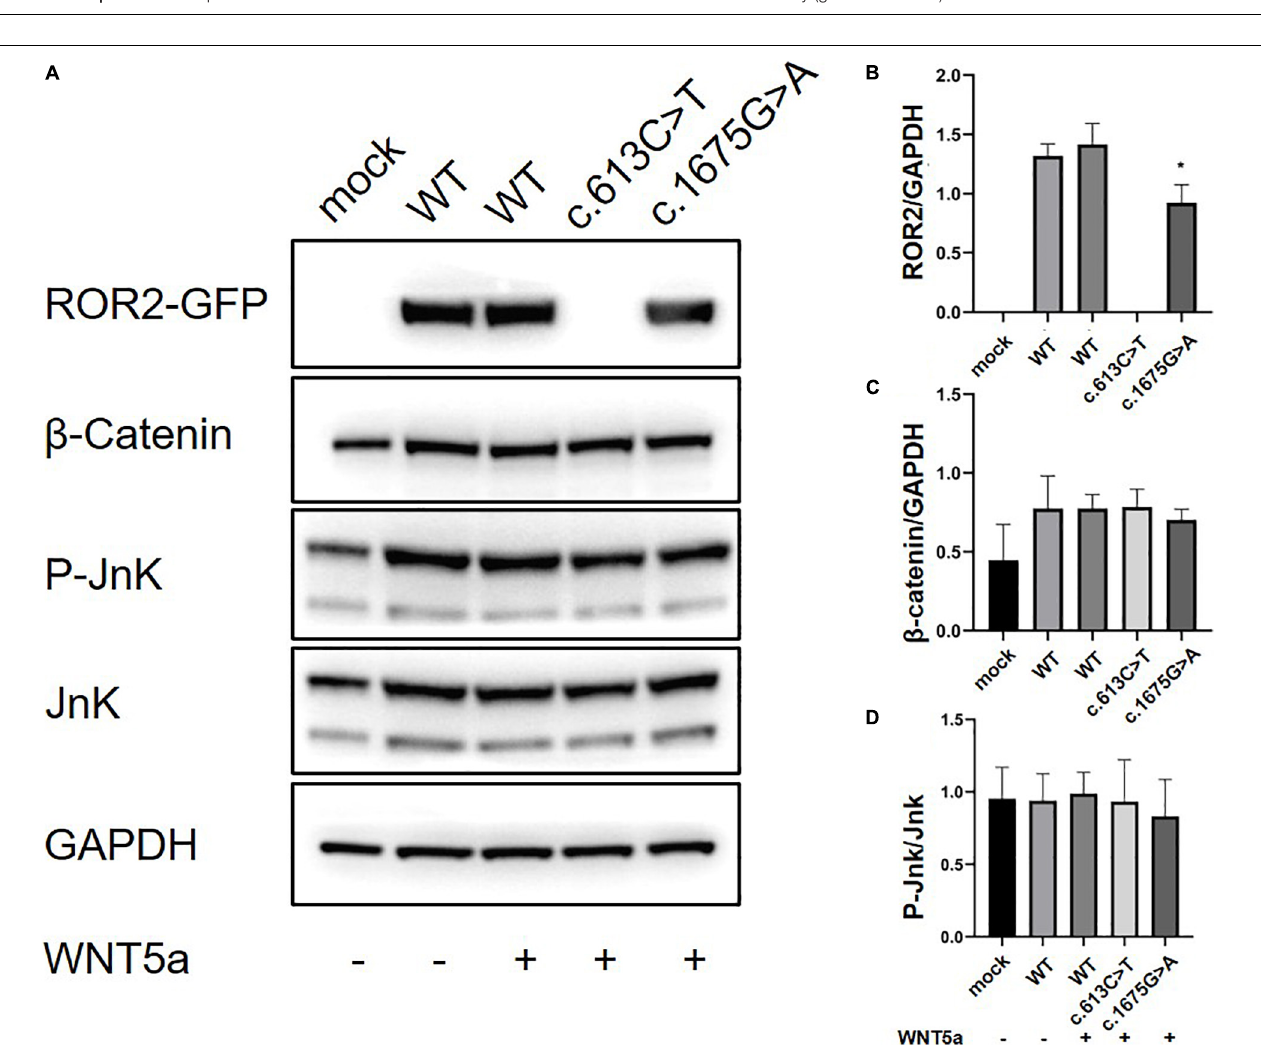
FIGURE 3 | Modulation of non-canonical Wnt signaling in HeLa cells with the supplementation of Wnt5a in general culture conditions. The ROR2-GFP, β -Catenin, P-JnK, JnK levels in HeLa cells with 100 ng/ml concentration of Wnt5a (A) Western blot for Ror2 [wild type (WT) and mutants] in HeLa cells. (B–D) Quantification of protein expression of different ROR2 constructs by ImageJ ( n = 3), * P < 0.05 vs. WT + Wnt5a 100